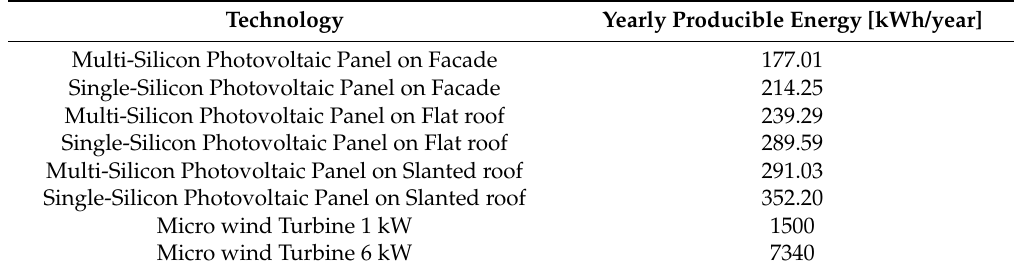
Table 3. Yearly producible energy for the technologies object of